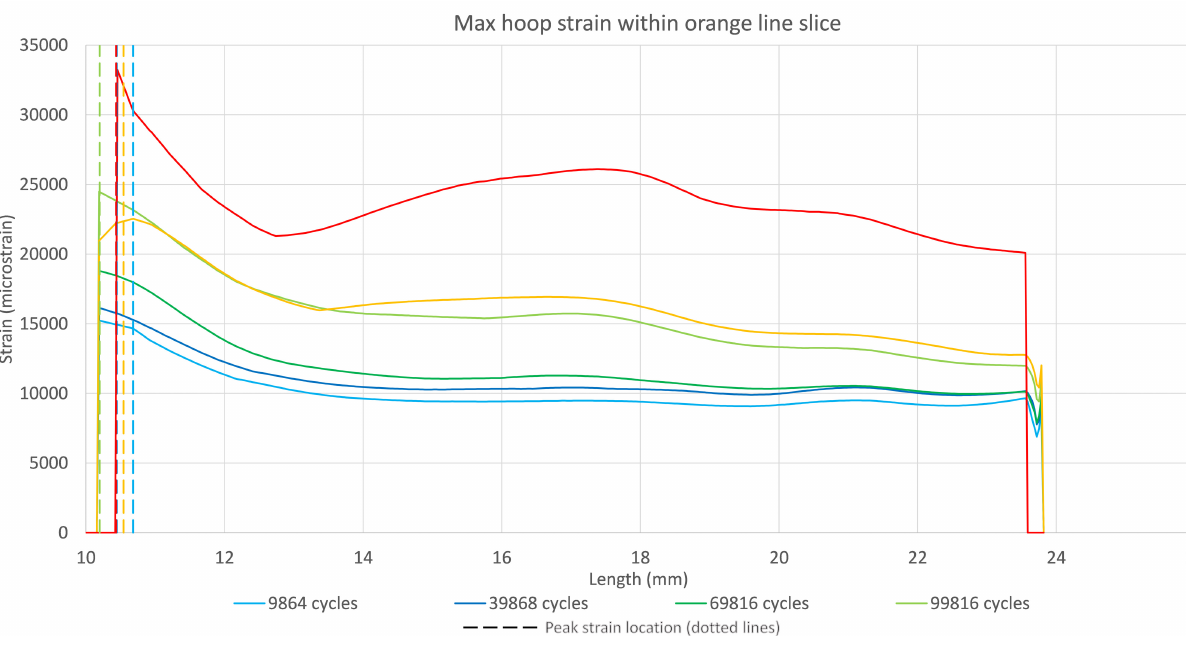
Figure 11: Maximum hoop strain over the orange line slice with location of peak strain plotted, despite high local strains, there is little redistribution due to low strains in the area surrounding peak strain at 10 mm.